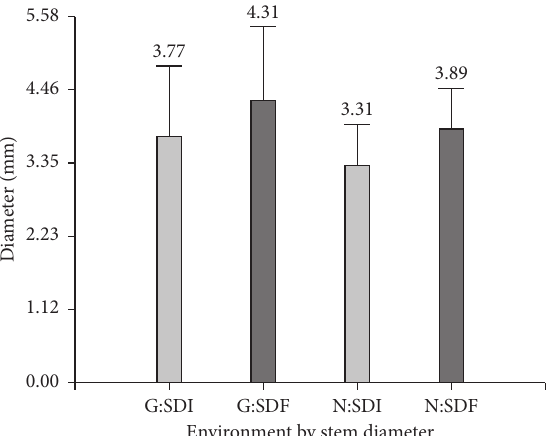
Figure 3: Stem diameter (mm) of coffee plants in nursery and greenhouse. G: greenhouse, N: nursery, ISD: initial stem diameter, FSD: final stem